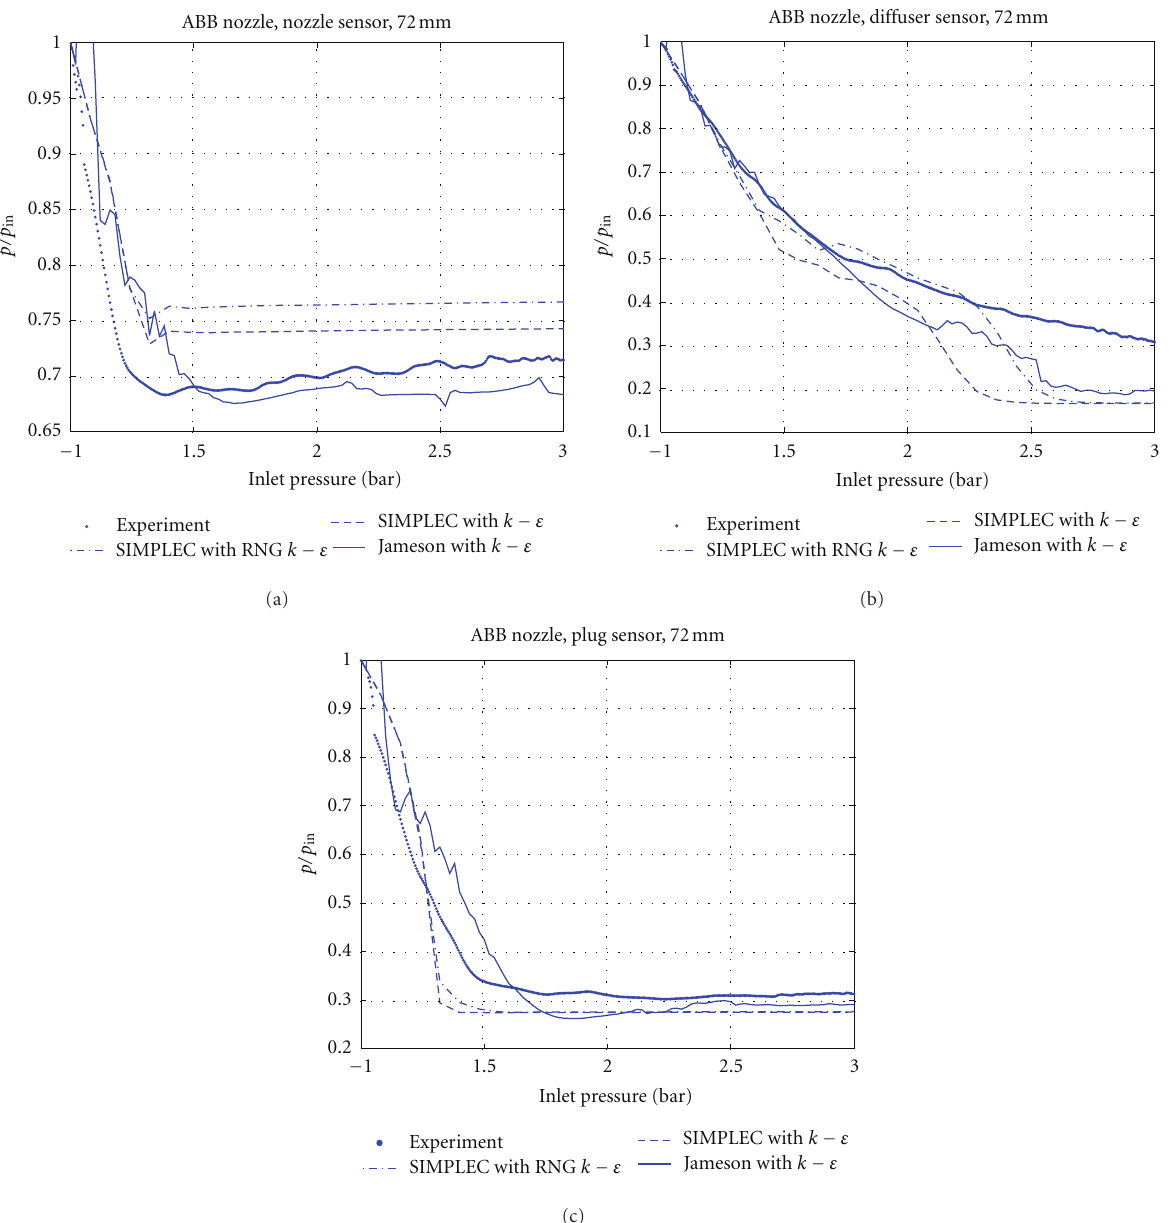
Figure 7: Comparison of the predicted pressure ratio and measurement for two di ff erent turbulence